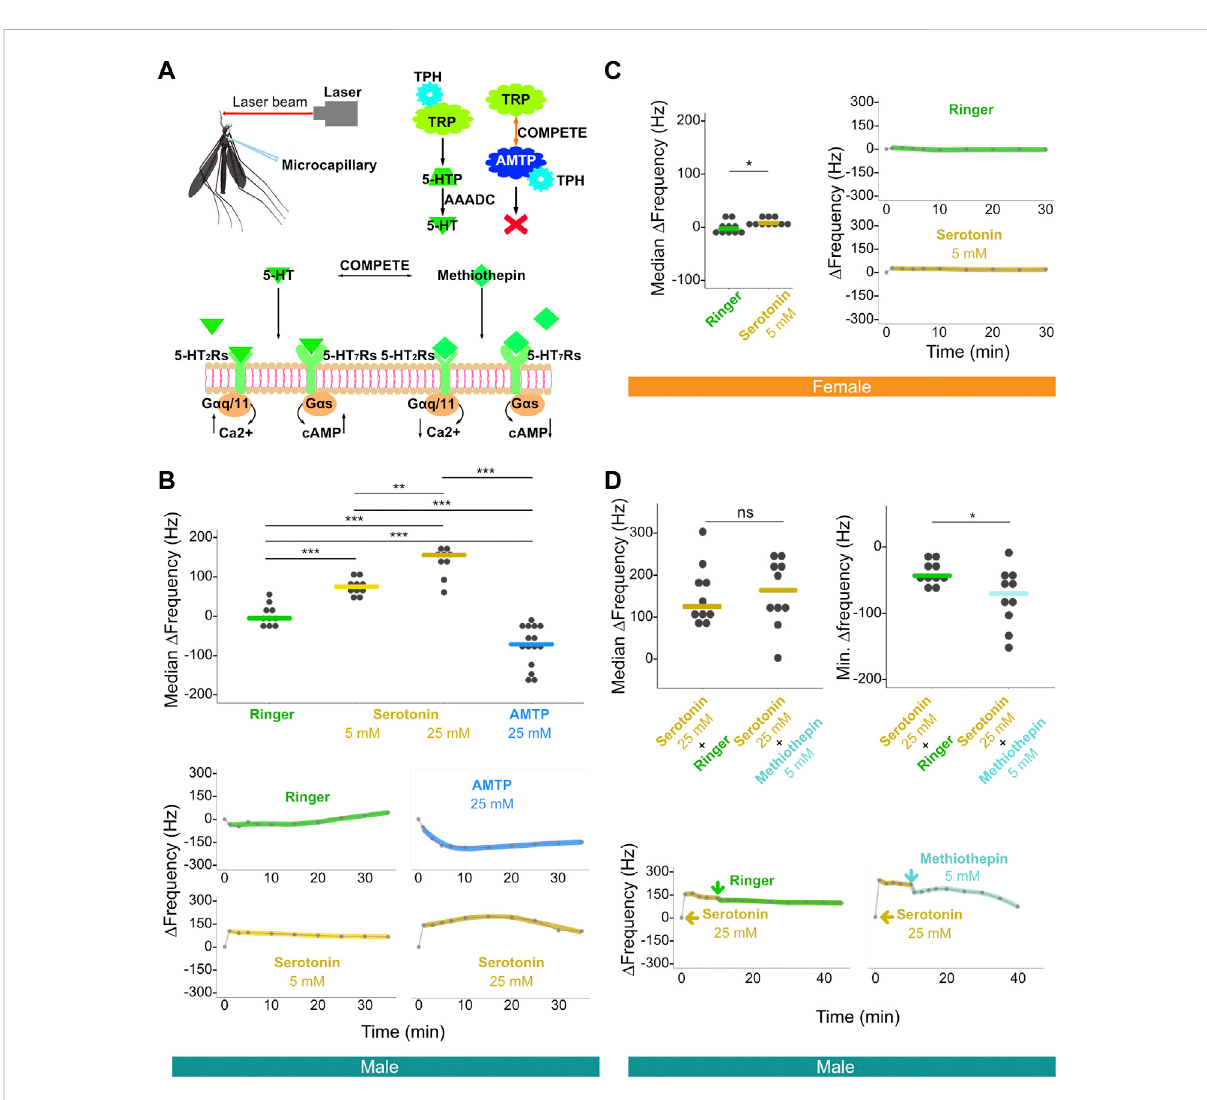
FIGURE 3 Injectionofserotonin-modulatingcompoundsin fl uencesmale,andtoalesserextentfemale, fl agellarearmechanicaltuningfrequency. (A) Diagramof laserexperimentalsetup.Thisillustrationincludesmicrocapillaryusedforinjections(upperleft),alpha-methyltryptophan(AMTP)workingmechanism(upper right) and serotonin receptor functional properties (bottom); 5-HT, serotonin; 5-HT 2 Rs, 5-HT 2 receptors; 5-HT 7 Rs, 5-HT 7 receptors; 5-HTP, 5- hydroxytryptophan;AAADC,aromaticL-aminoaciddecarboxylase;AMTP,alpha-methyltryptophan;TPH,tryptophanhydroxylase;TRP,tryptophan. (B) Median Δ Frequencydatafor Ringer,5 mMserotonin,25 mMserotonin,or 25 mMAMTPmalesingleinjectiongroups(top).Signi fi cantdifferencesidenti fi ed via ART ANOVA between groups are labelled. Dots represent median Δ Frequency for individuals. Bars represent the median of the median Δ Frequency for eachgroup.Representativeplotsfromindividualsthatshowthetimeseriesofchangesin fl agellarearmechanicaltuningfrequency( Δ Frequency)over35 min (bottom) following Ringer (top left), 25 mM AMTP (top right), 5 mM serotonin (bottom left) or 25 mM serotonin (bottom right) injection. Injection occurred immediately after the fi rst recording at zero min. Dots represent frequency values extracted from collected data. Solid lines in the bottom panels represent loess fi tstothesedatapoints. (C) Median Δ Frequencydata(left)forRinger(left)or5 mMserotonin(right)femalesingleinjectiongroups.Signi fi cantdifferences identi fi ed via ART ANOVA between groups are labelled. Dots represent median Δ Frequency for individuals. Bar represents the median of the median Δ Frequencyforeachgroup.Representativeplotsfromindividualsshowingchangesin fl agellarearmechanicaltuningfrequencyover35 min(right)following Ringer (top) or 5 mM serotonin (bottom) injection. Injection occurred immediately after the fi rst recording at zero min. Dots represent frequency values extracted from collected data. Solid lines in the right panels represent loess fi tsto these datapoints. (D) Median Δ Frequency data (top left) following 25 mM serotonininjectionprior to asecondinjectionofeither Ringer (left), or 5 mMmethiothepin (right)maleinjectiongroups. No signi fi cantdifferencesbetween groupswereidenti fi ed via ARTANOVA.Dotsrepresentmedian Δ Frequencyforindividualsandbarrepresentsthemedianofthemedian Δ Frequencyforeach group. Minimum Δ Frequency (Min. Δ Frequency) data (top right) after a second injection of either Ringer (left), or 5 mM methiothepin (right) male injection groupsfollowing25 mMserotonininjection.Signi fi cantdifferencesidenti fi ed via ARTANOVAbetweengroupsarelabelled.Dotsrepresentmin Δ Frequency for individuals and bar represents the median of the min Δ Frequency for each group. Representative plots from individuals that show the time series of changesin fl agellarearmechanicaltuningfrequency( Δ Frequency)overthe40mintimecourse(bottom)ofaprimaryinjectionof25mMserotoninfollowed byasecondaryinjectionofeitherRinger(left)or5 mMmethiothepin(right)injection.25 mMserotonininjectionoccurredimmediatelyafterthe fi rstrecording at zero min, and the second injection occurred immediately after the recording at 10 min. Dots represent frequency values extracted from collected data. Solid lines in the bottom panels represent loess fi ts to these data points. (B – D) ns, p > 0.05; *, p ≤ 0.05; **, p ≤ 0.01; ***, p ≤